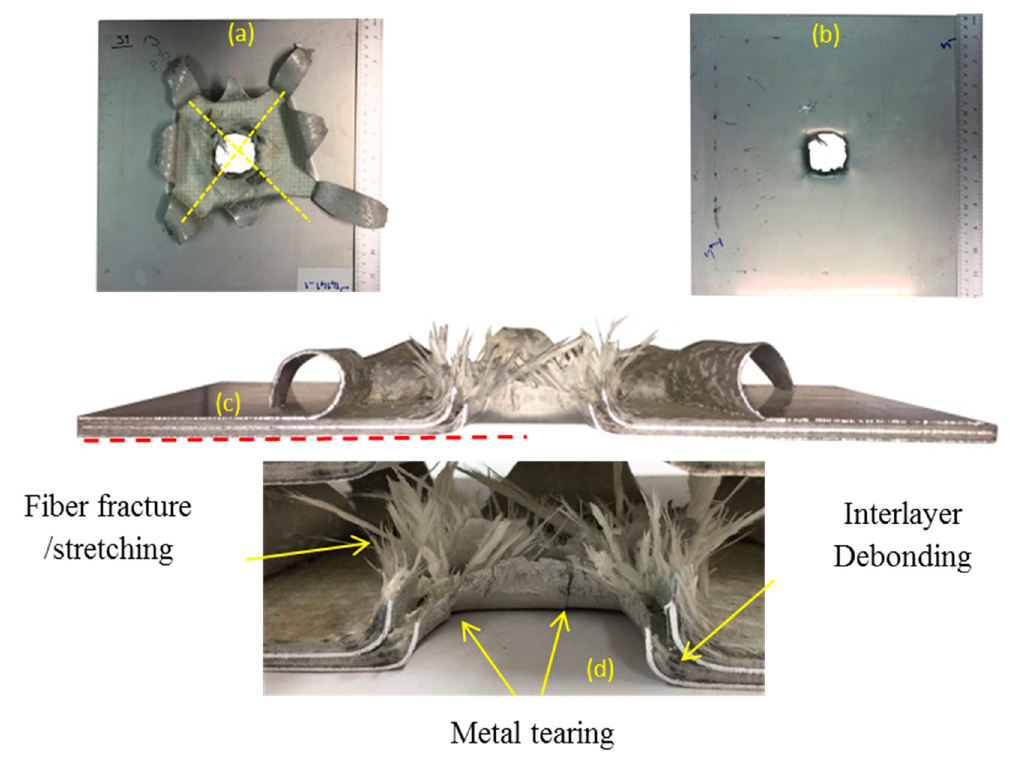
Figure 5. Sample code S14141-1 in impulse 16.5 N.s ( a ) back face, ( b ) front face, ( c ) cross section, ( d ) close-up view of cross section.